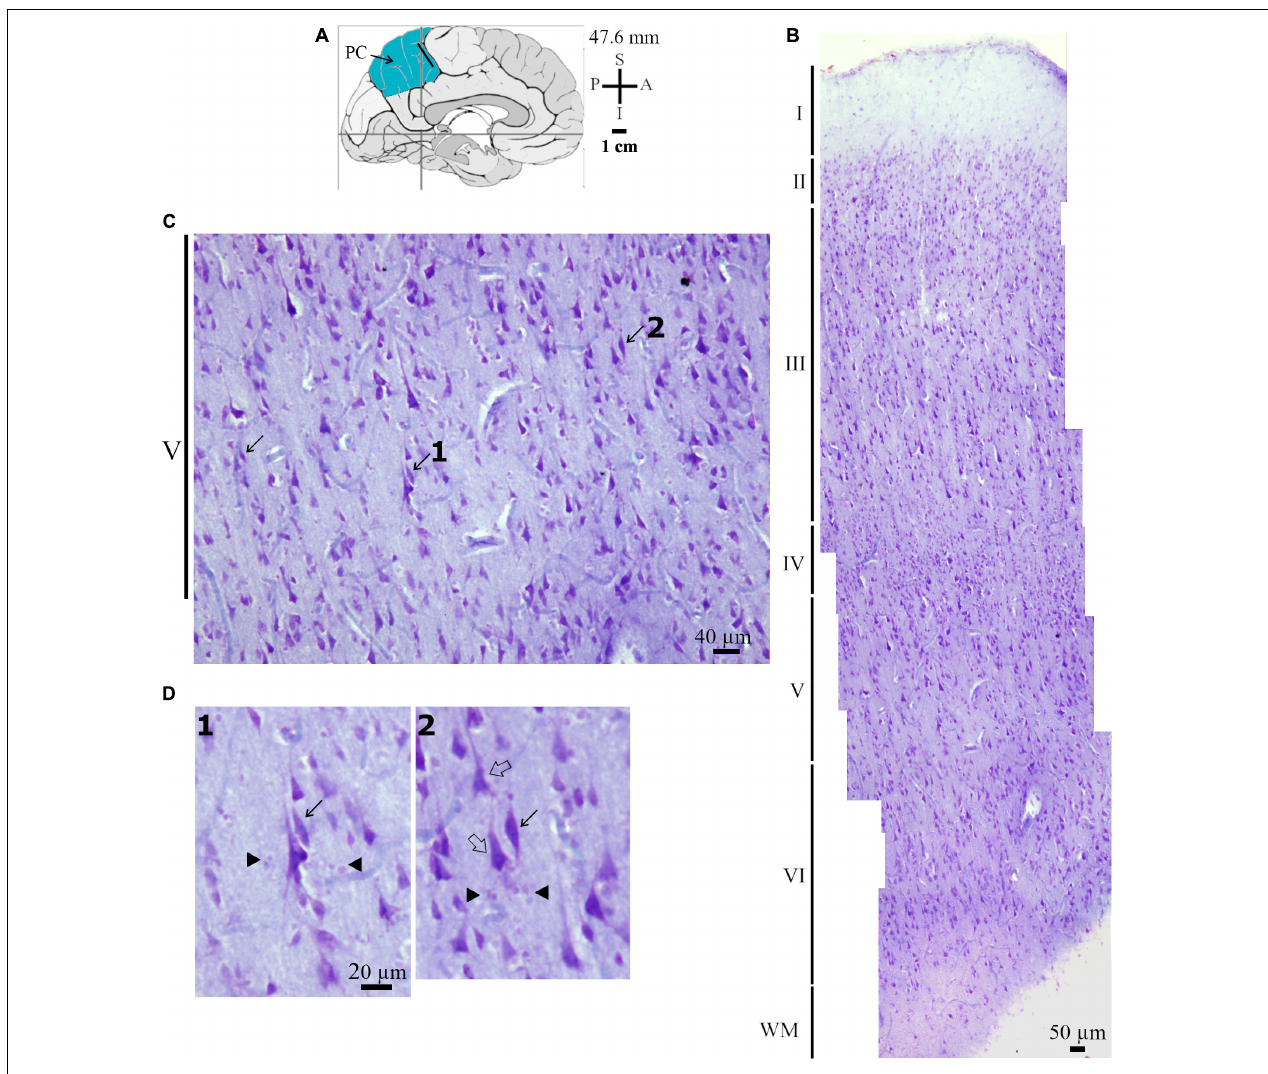
FIGURE 2 | (A) Schematic drawing of the medial view of the human brain and the location of the anterior region of the precuneus (PC, highlighted in blue), in this case 47.6 mm posterior to the midpoint of the anterior commissure. The dark bar indicates approximately the place where histological data were obtained. Adapted from Mai et al. (2008, 2016). Coordinates: I, inferior; L, lateral; M, medial; S, superior. (B) Photomicrograph of Nissl-stained cells in layers I to VI in the anterior PC. WM, white matter. (C) Photomicrograph in higher magnification of Nissl-stained cells in the layer V of the human PC as shown in (B) . The spindle-shaped neurons (pointed by solid arrows) are close to pyramidal neurons and other local cells in the cortical layer V and in the transition to layer VI. (D) Further details for the morphology of the spindle-shaped neurons pointed and numbered 1 and 2 in (C) . Note their characteristic elongated cell body and two perpendicularly oriented primary dendrites, one with an ascending and another with a descending spatial orientation in the neuropil. Compare these spindle-shaped cells to the neighboring stained pyramidal neurons (examples indicated by an open arrow). Adjacent glia cells are also present (indicated by a solid arrow head). Scales are shown in each figure. Image adjustment of contrast and brightness made with Photoshop CS3 (Adobe Systems, Inc., United States).